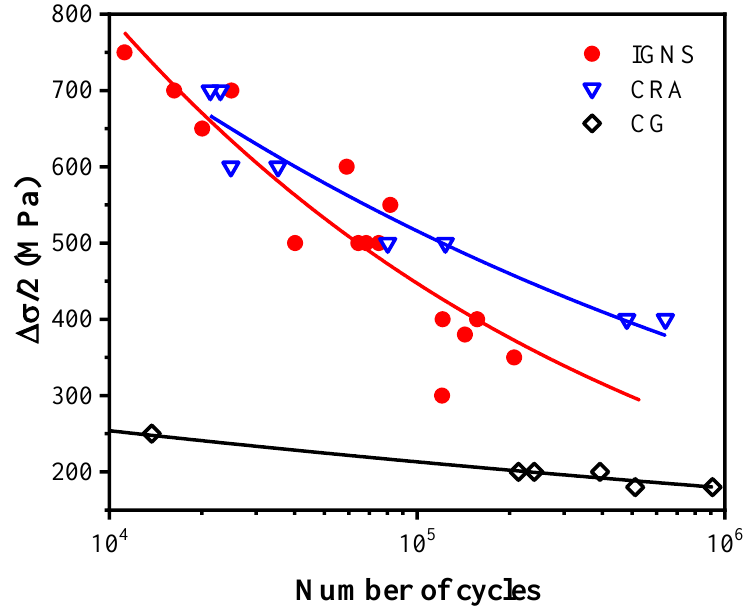
Figure 6. S – N curves of samples in various conditions. The fitted lines follow the Basquin equation. Figure 6. S–N curves of samples in various conditions. The fitted lines follow the Basquin